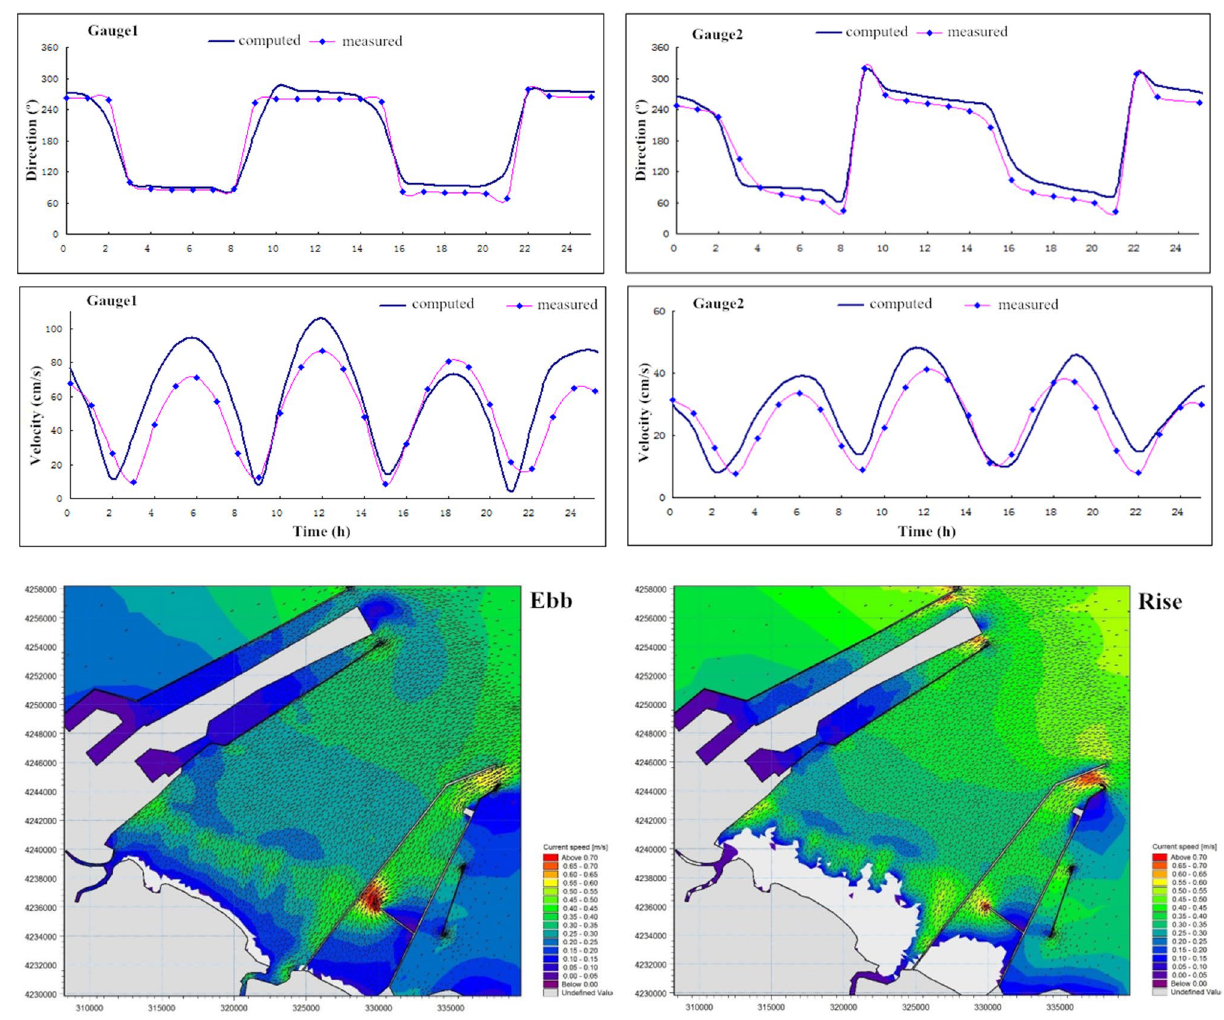
Figure 6. Time series of the current at 2 measurement points and the snapshots of velocity field at 2 tidal phases (processed by Mike 21 at https ://www.mikep owere dbydh i.com/produ Fig. 6 compare the simulated currents to the measurement data at the two gauge locations. The velocities and flow directions are computed well characterized with slightly overestimation in magnitude. Two snapshots of the velocity field for the study area during ebb and rise periods of the tide are respectively shown in the lower two panels of Fig. 6, featuring up to 0.5 m/s flow speed as the consequence of the mild topography. The bottom friction follows the Manning law with the spatial changing roughness coefficient n from 0.03 to 0.045 obtained by the calibration with tidal elevations. Validation results indicate the numerical model is fairly competent to predict the hydrodynamic environment during a storm event. However, sediment models feature more approxi- mation/assumptions compared to the hydrodynamic theory and are highly sensitive to the computational accu- racy of near-bed flows in coastal water. Therefore, sediment transport modelling is currently of limited accuracy, especially for short time duration and complex distribution of sediment composition. Vulnerability assessment Typhoon Rumbia. Typhoon Rumbia made its landfall at Shanghai on August 17, 2018 and entered the Bohai Sea from the mainland as an extratropical cyclone on August 20, 2018. The maximum storm surge was around 1 m at the study site. The left panel of Fig. 7 shows the significant wave height reached 1–2 m inside the habitat with two obvious wave shoaling/breaking belts 1 km and 5 km off the shoreline. The middle panel of Fig. 7 presents the computed spatial distribution of the net changes in the seabed right after the storm. Inside the habitat, the erosion depth ranges from 2 to 6 cm with a maximum of 8.3 cm, while the sedimentation thickness was mainly below 5 cm with a maximum of 7.2 cm. The right panel of Fig. 7 shows the damage states within the habitat domain assessed by incorporating the computed bed changes into the loss probability function, for the majority of the clams with averaged shell length of 3.5 cm. Level I (red) stands for over 75% loss while level IV (blue) represents less than 35% loss, in accordance with the criteria in Fig. 3b. The severe damage were scattered